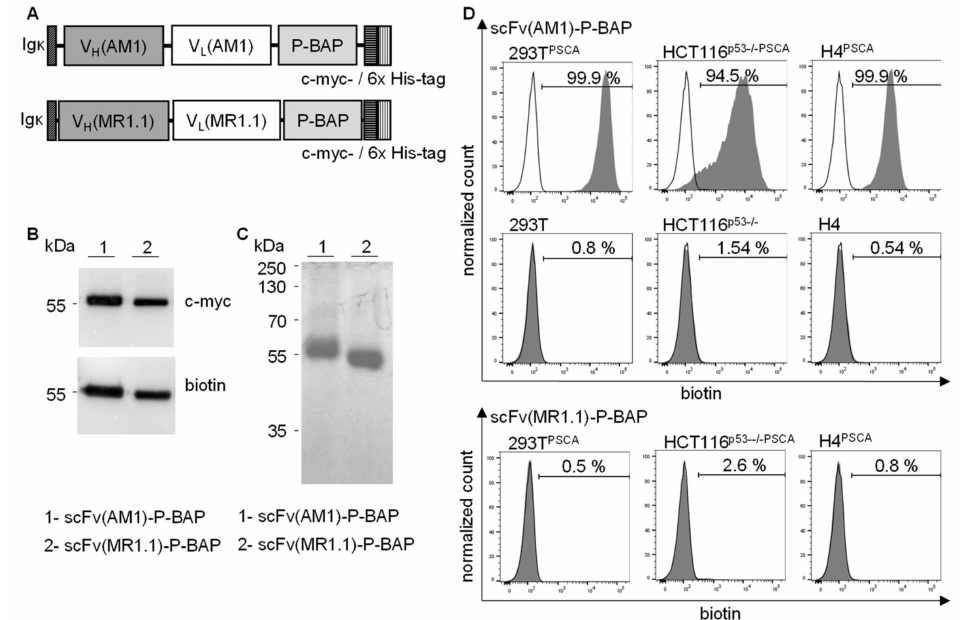
Figure 2. Production and characterization of recombinant biotinylated scFv(AM1)-P-BAP and scFv(MR1.1)-P-BAP. ( A ): Schematic presentation of the scFv(AM1)-P-BAP and control antibody scFv(MR1.1)-P-BAP protein domains. ( B ): Western Blot analysis of biotinylated scFv(AM1)-P-BAP and scFv(MR1.1)-P-BAP using anti-c-myc and anti-biotin antibodies. Uncropped Western Blots can be found at Figure S4. ( C ): Coomassie Brilliant Blue-stained polyacrylamide gel of purified scFv(AM1)-P- BAP and scFv(MR1.1)-P-BAP recombinant antibody derivatives. ( D ): Flow cytometry analysis of 293T, HCT116 p53 − / − , H4, 293T PSCA , HCT116 p53 − / − PSCA and H4 PSCA cells stained with